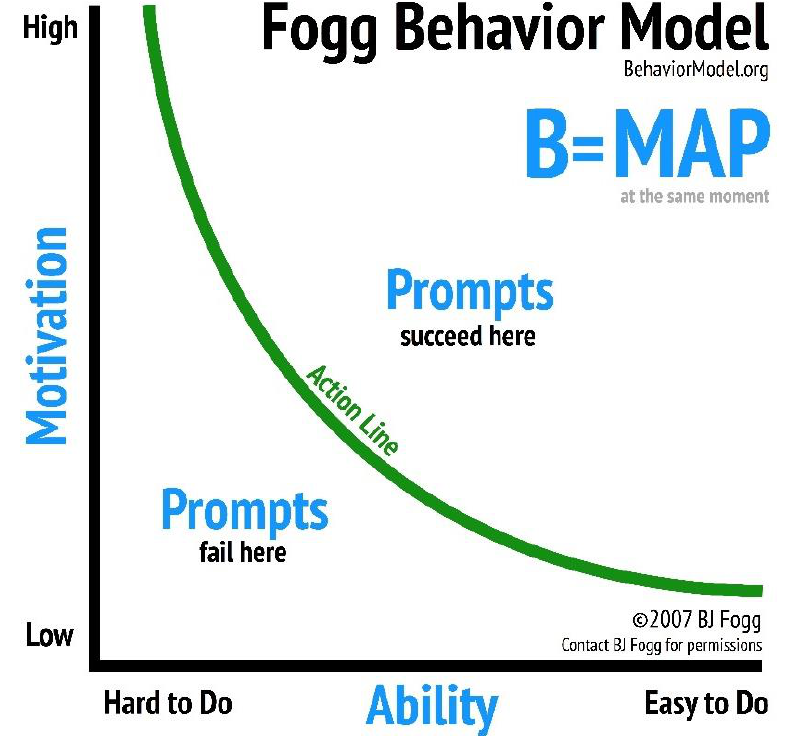
Figure 1. Fogg Behavior Model.